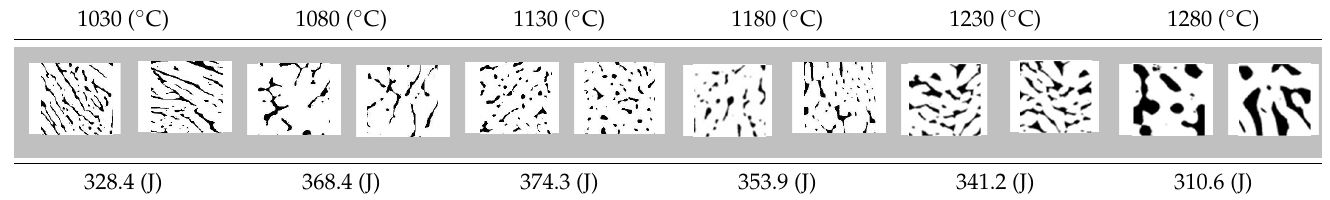
Table 3. Heat treatment temperature (°C), micrograph images, and impact energy (J).